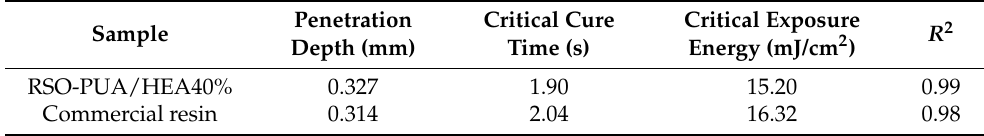
Table 5. The printing parameters of RSO-PUA/HEA40% resin and commercial resin. Penetration Depth Sample Critical Cure Time (s) (mm) Commercial resin